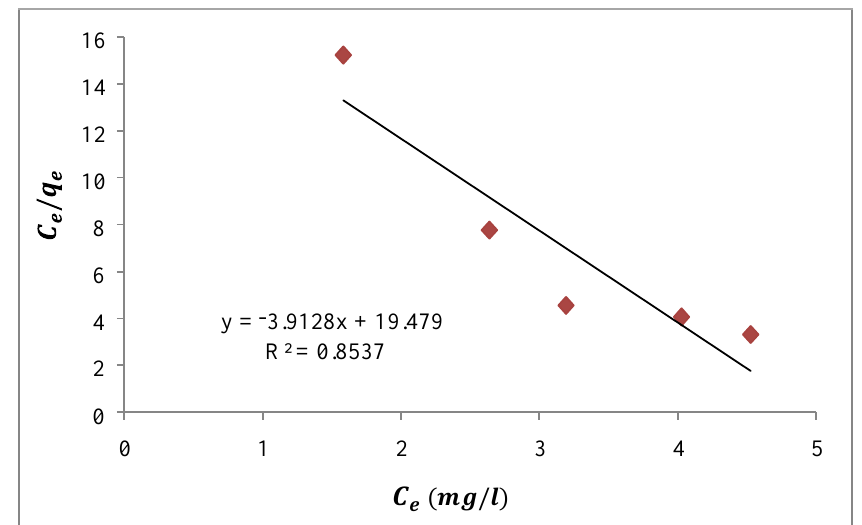
Figure 4. Langmuir isotherm for peanut shell